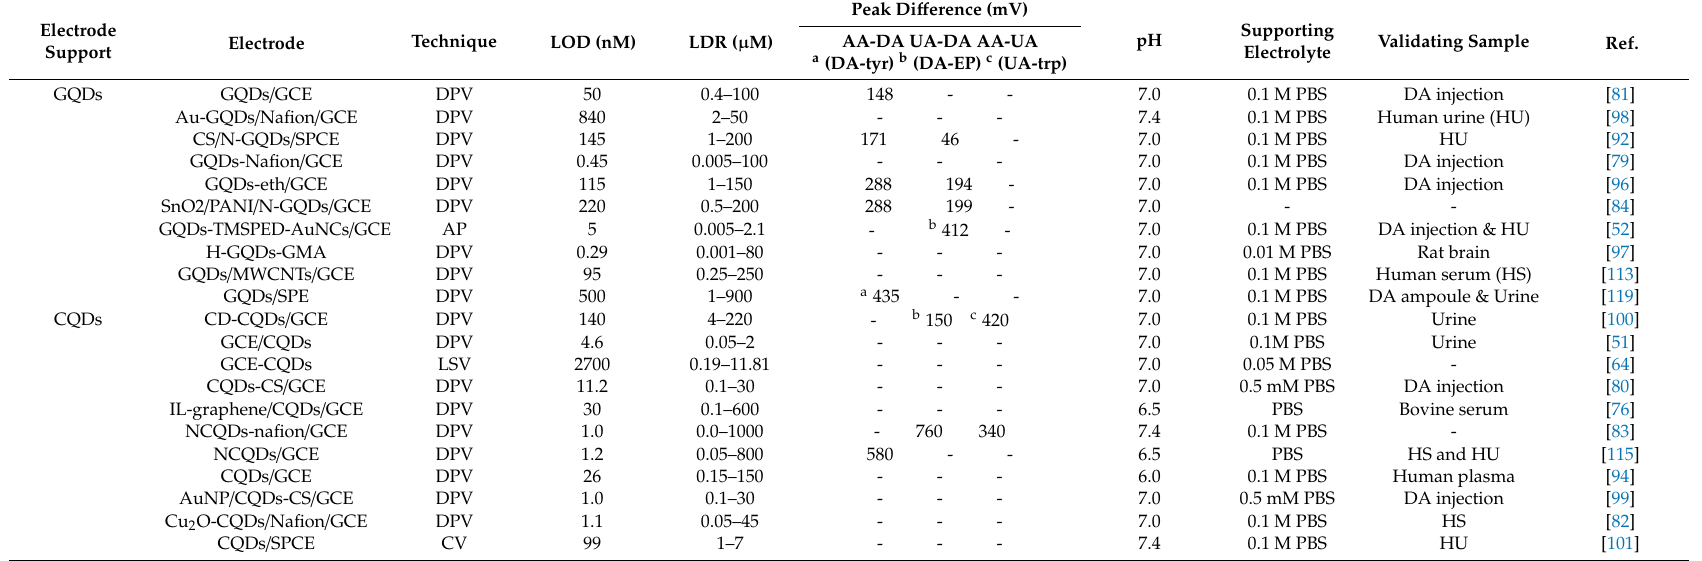
Table 2. Table of the figures of merit for dopamine (DA) determination using graphene and carbon quantum dots (GQDs &